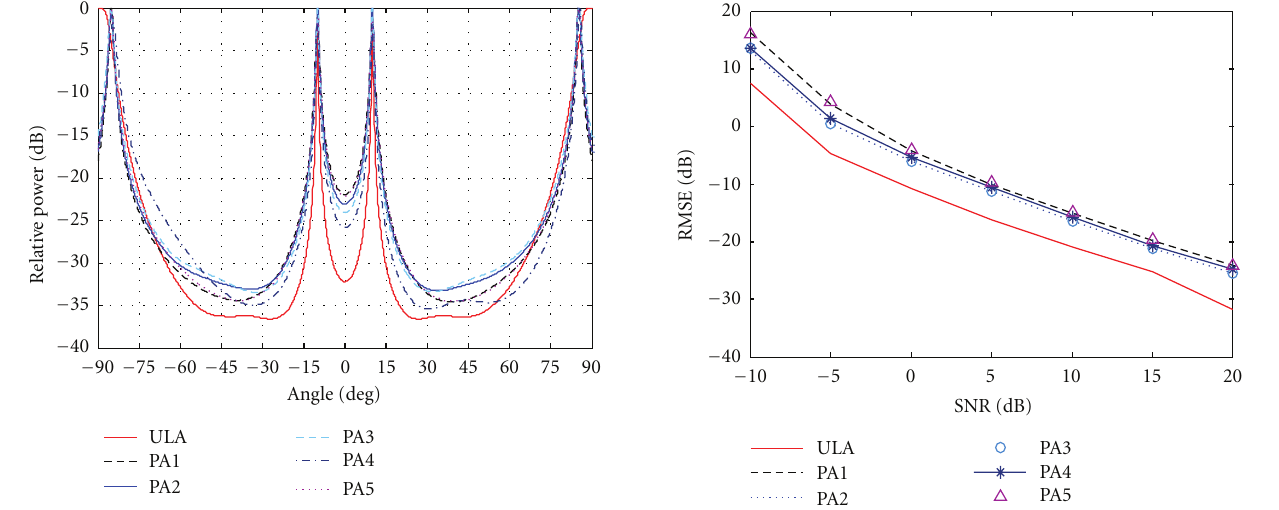
Figure 4: Total RMSE of the MUSIC algorithm for di ff erent configurations where signals are arriving at boresight